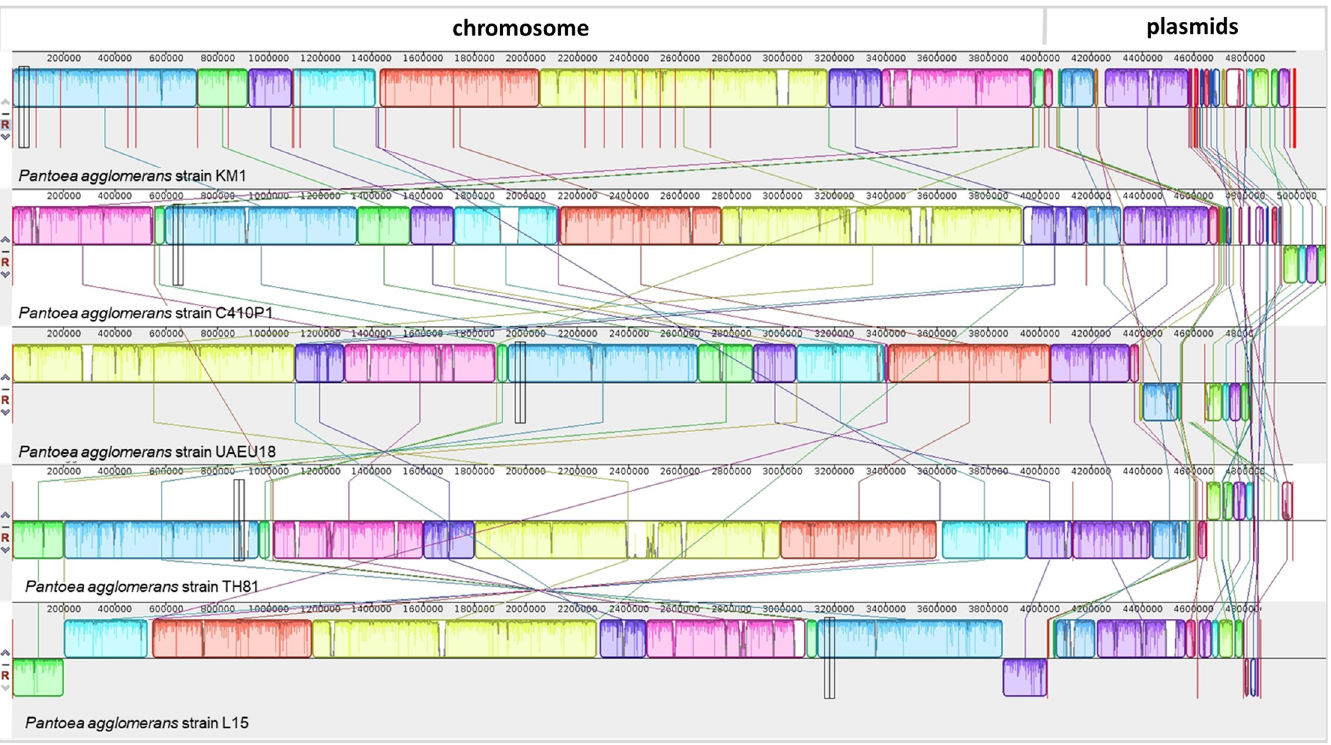
Fig 3. Genome alignments showing synteny blocks among P . agglomerans strains obtained using progressive Mauve. P . agglomerans KM1 were compared with other closely related strains namely C410P1, UAEU18, TH81 and L15. Each genome is laid out horizontally with homologous segment outlined as colored rectangles. Each same color block represents a locally collinear block (LCB) or homologous region shared among genomes. Rearrangement of genomic regions was observed between the two genomes in terms of collinearity. Inverted regions relative to KM1 are localized in the negative strand indicated by genomic position below the black horizontal centerline in the Mauve